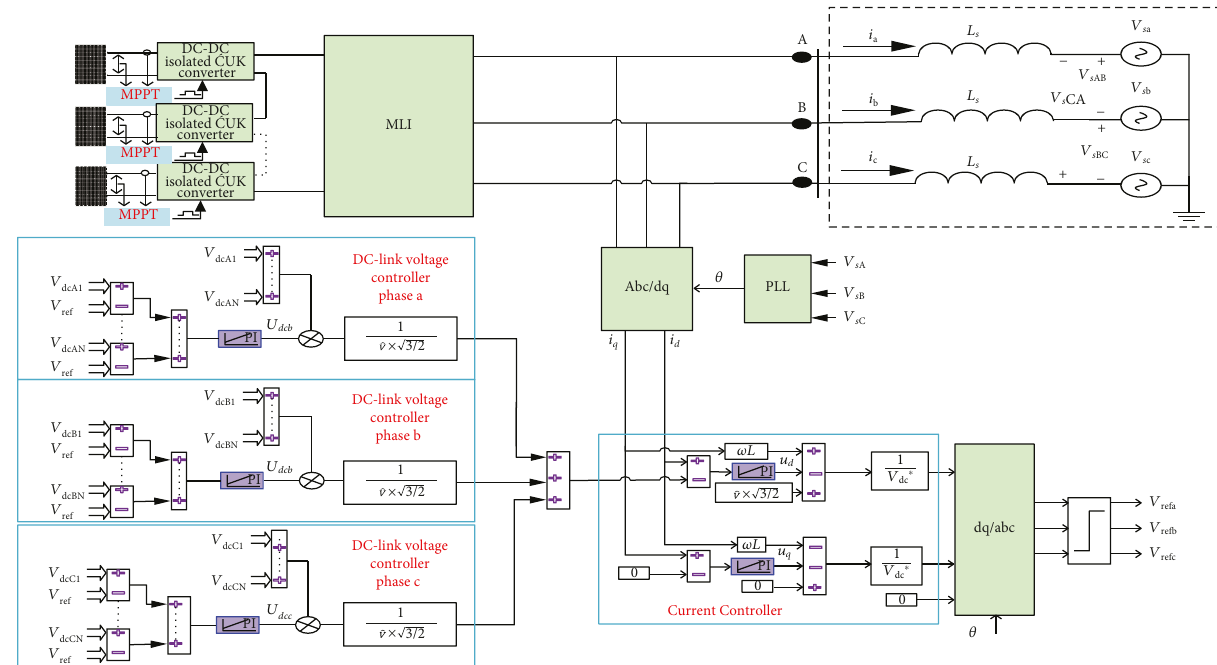
Figure 5: The proposed control strategy of cascaded H-bridge MLI topology.